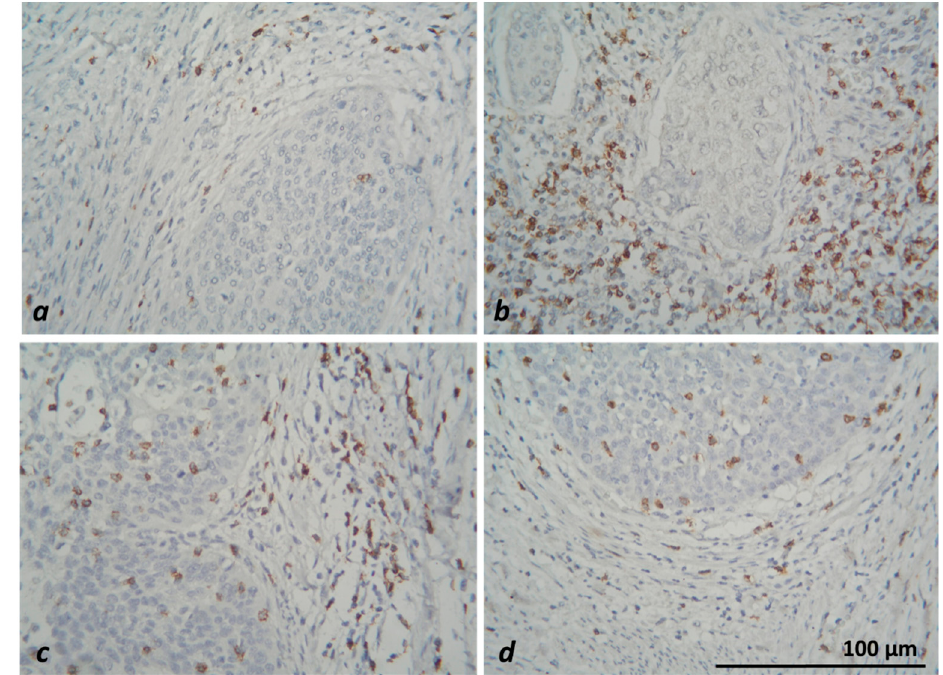
Figure 3. Microscopic evaluation of IHC-stained CD8+ T-lymphocyte subtypes (colored brownish) in CC—low intratumoral and stromal ( a ), low intratumoral and high stromal ( b ), high intratumoral and stromal ( c ) and high intratumoral and low stromal ( d ) concentration of positive cells, ×400.